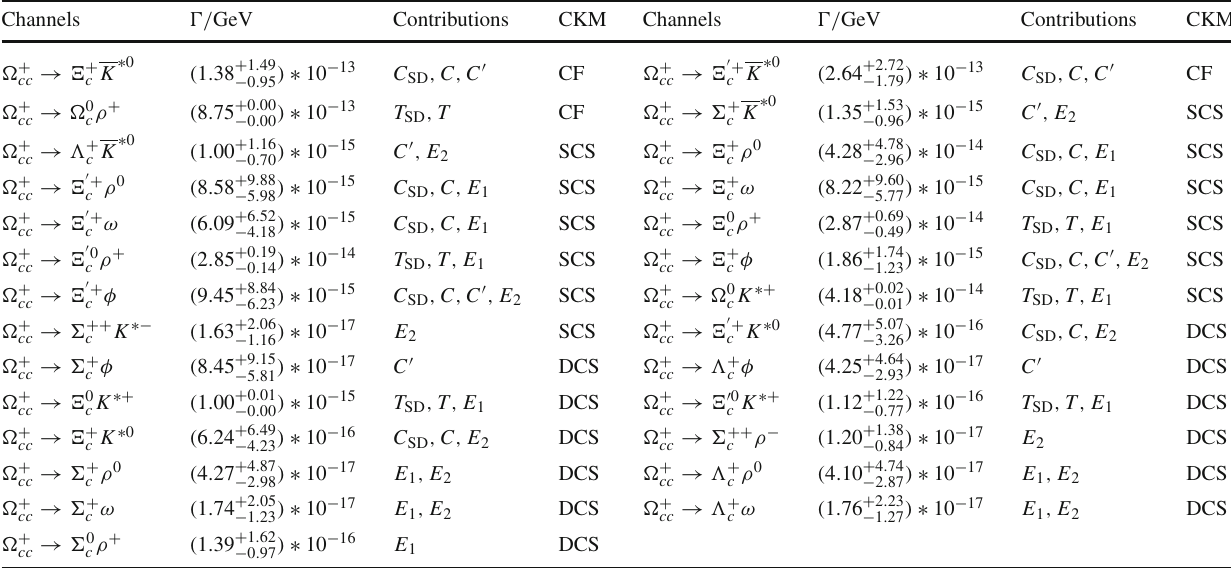
Table 4 Our results for decay widths of (cid:4) + cc → B c V and correspond- ing topological contributions. The “CF”, “SCS” and “DCS” represent CKM favored, singly CKM suppressed and doubly CKM suppressed